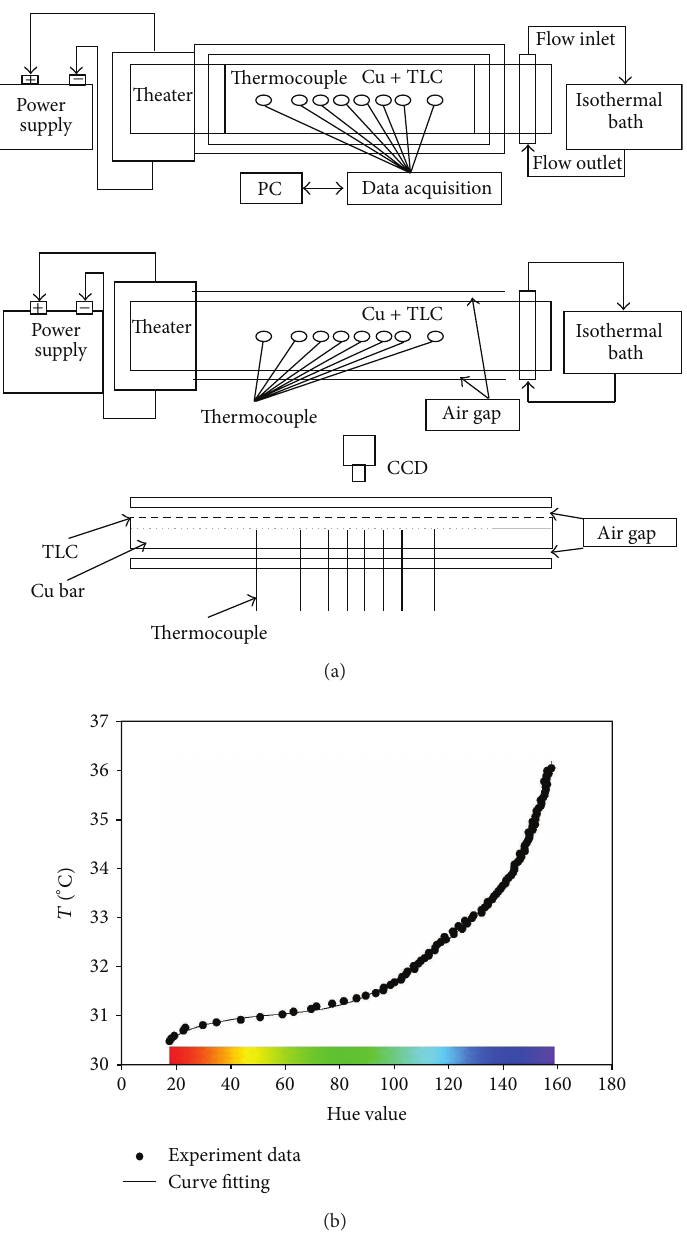
Figure 5: (a) Calibration setup and (b) T-hue relation of the R31C5W